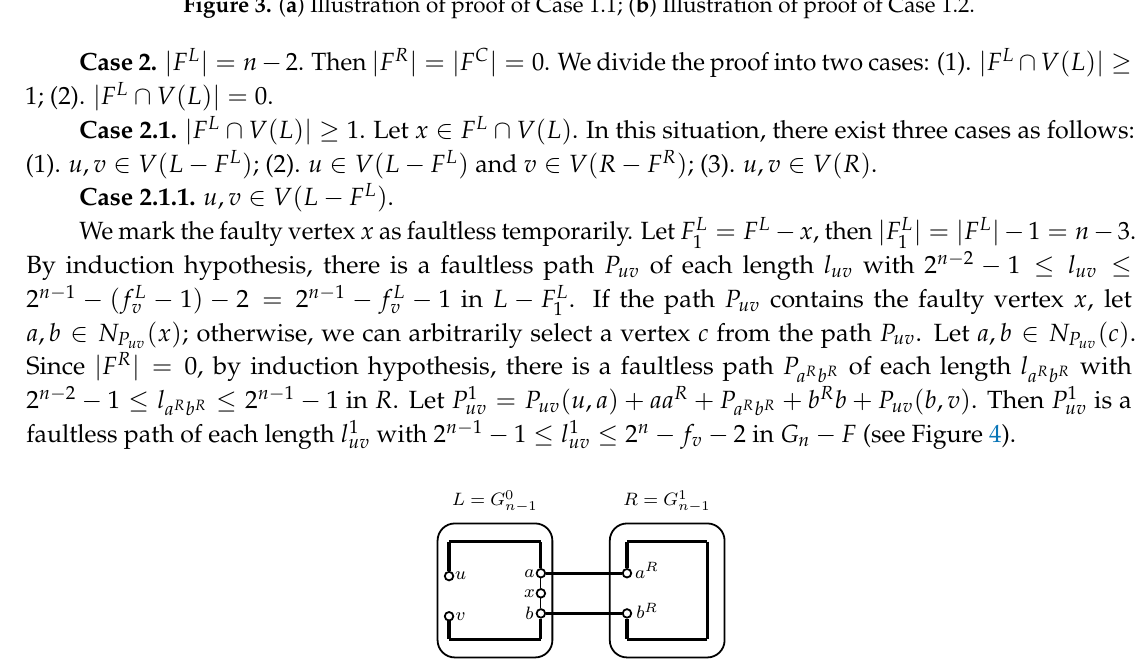
Figure 4. Illustration of proof of Case